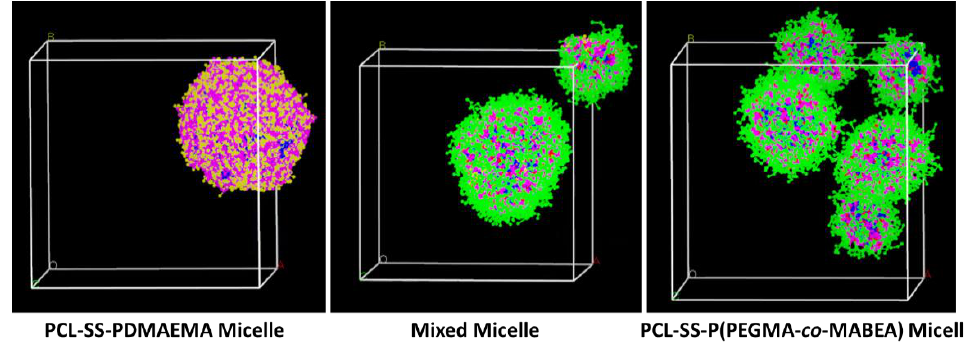
Figure 9. The micelles self-assembled from different copolymers and their mixtures, PCL-SS- PDMAEMA micelle, PCL-SS-P(PEGMA- co -MAEBA) micelles and the mixed